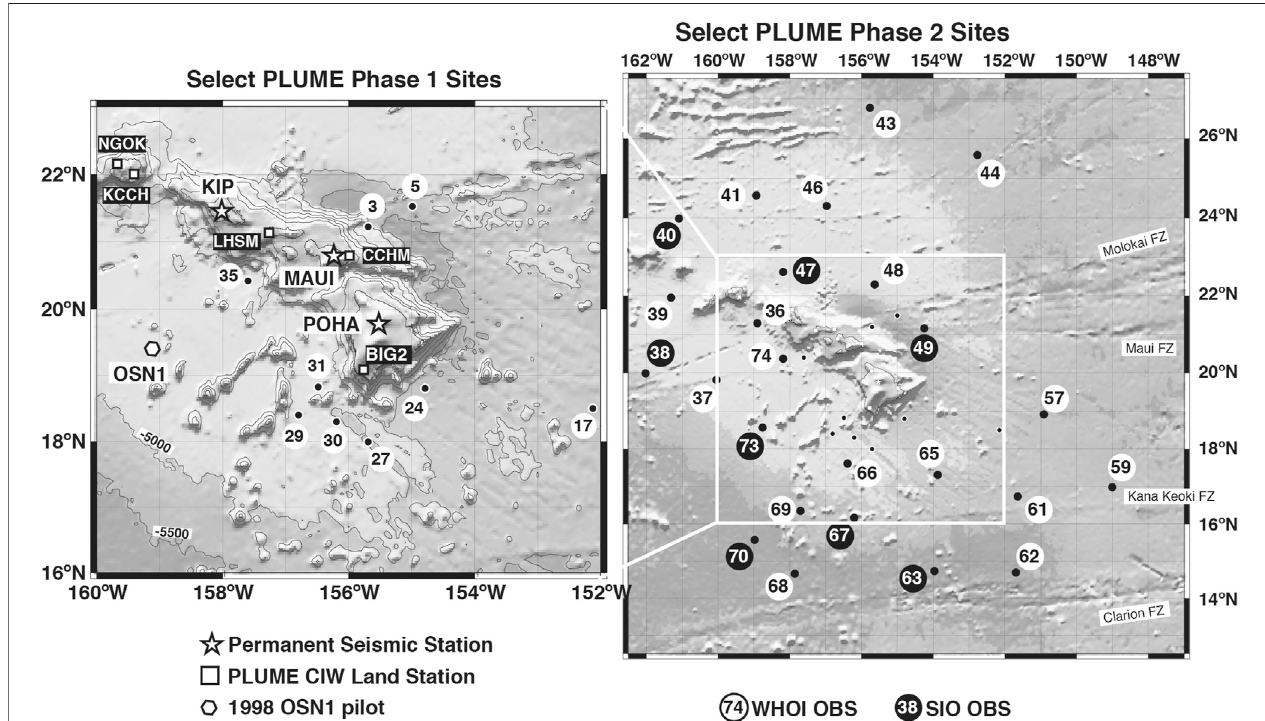
FIGURE1| SitelocationsofthetwodeploymentphasesoftheHawaiianPLUMEproject.Phase1operatedfromJanuary2005throughJanuary2006andphase2 from April 2006 through June 2007. Only the sites discussed in this paper are shown. See Laske et al. (2009) for complete station and deployment history. The OSN1 labelmarksthelocation ofthe1998OSNpilotdeployment(Dziewonskietal.,1991).Alsoshown areGSN observatory stations: KIP(Kipapa, Oahu)isjointlyoperated by GEOSCOPE and the U.S. Geological Survey (USGS). The primary instrument is a Wielandt-Streckeisen STS-1. The primary sensor at POHA (Pohakuloa, Hawaii), operated by the USGS, is a Teledyne-Geotech KS54000 borehole seismometer. MAUI was operated by GEOFON and featured a Wielandt-Streckeisen STS-2. The primary sensor at USGS-run MIDW (Midway Island, 28.22 ° N, 177.37 ° W, not shown), is a STS-2.